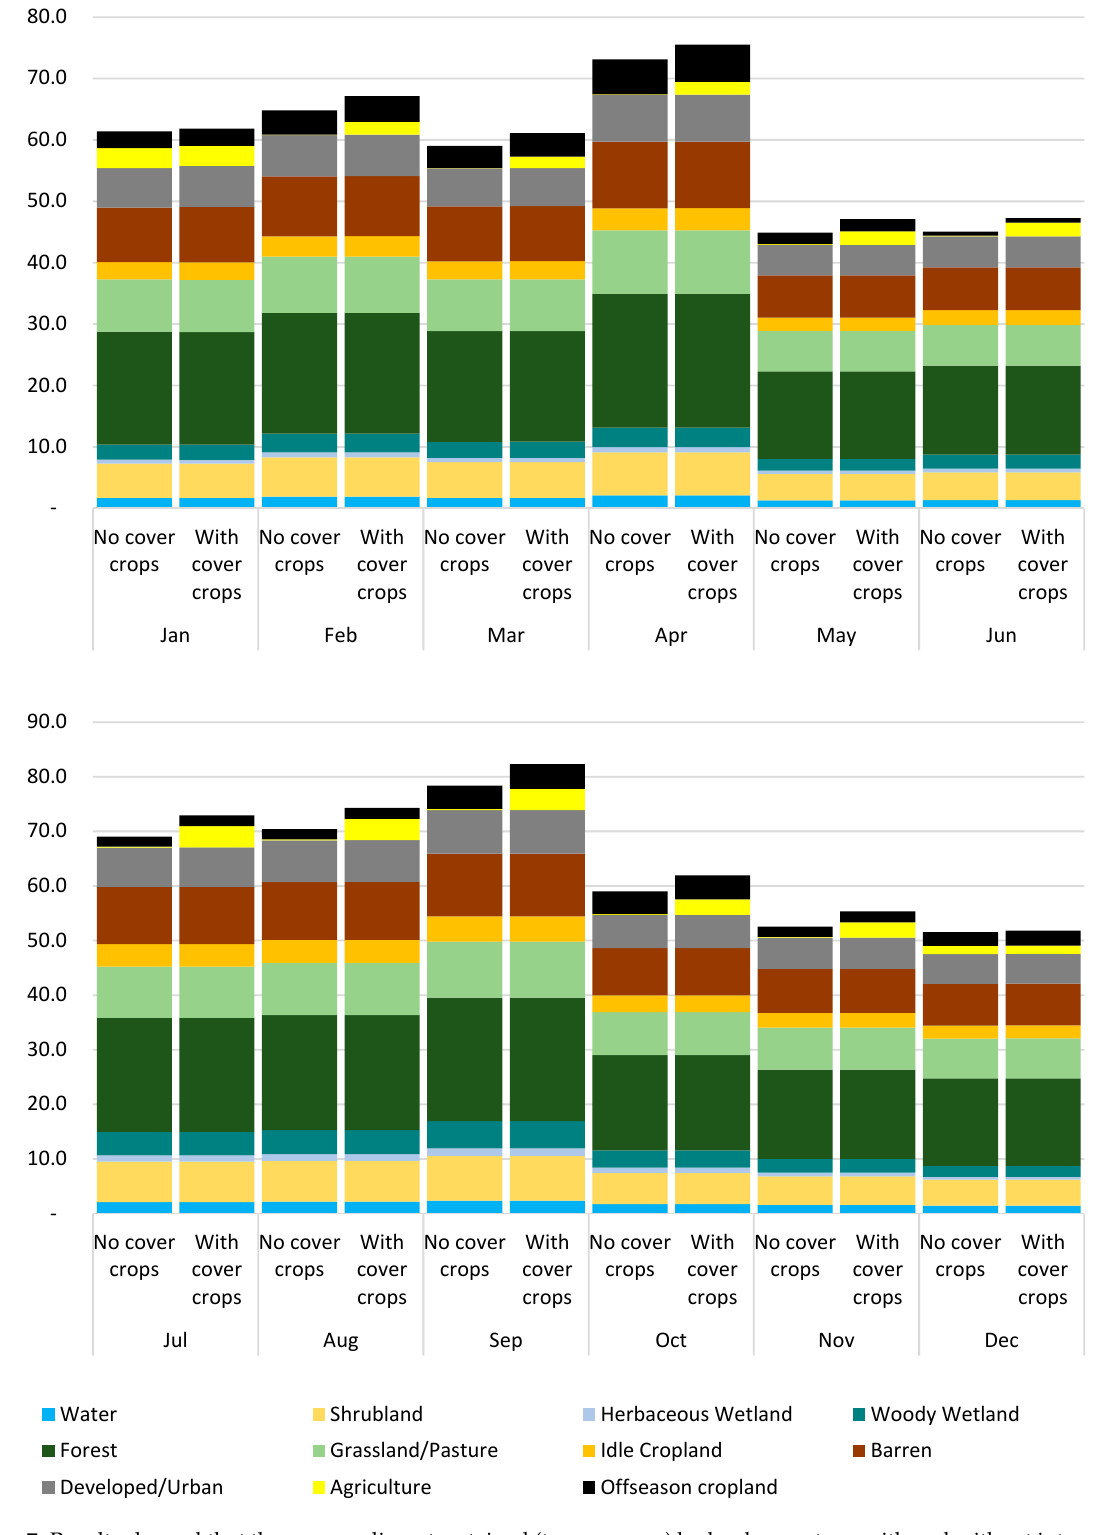
Figure 7. Results showed that the mean sediments retained (tons per acre) by land cover type with and without intervention varied per month.